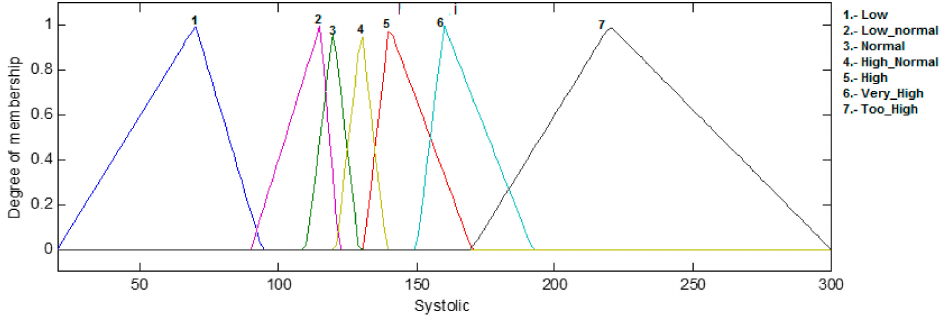
Figure 17. Systolic input for the fuzzy logic classifier 4.